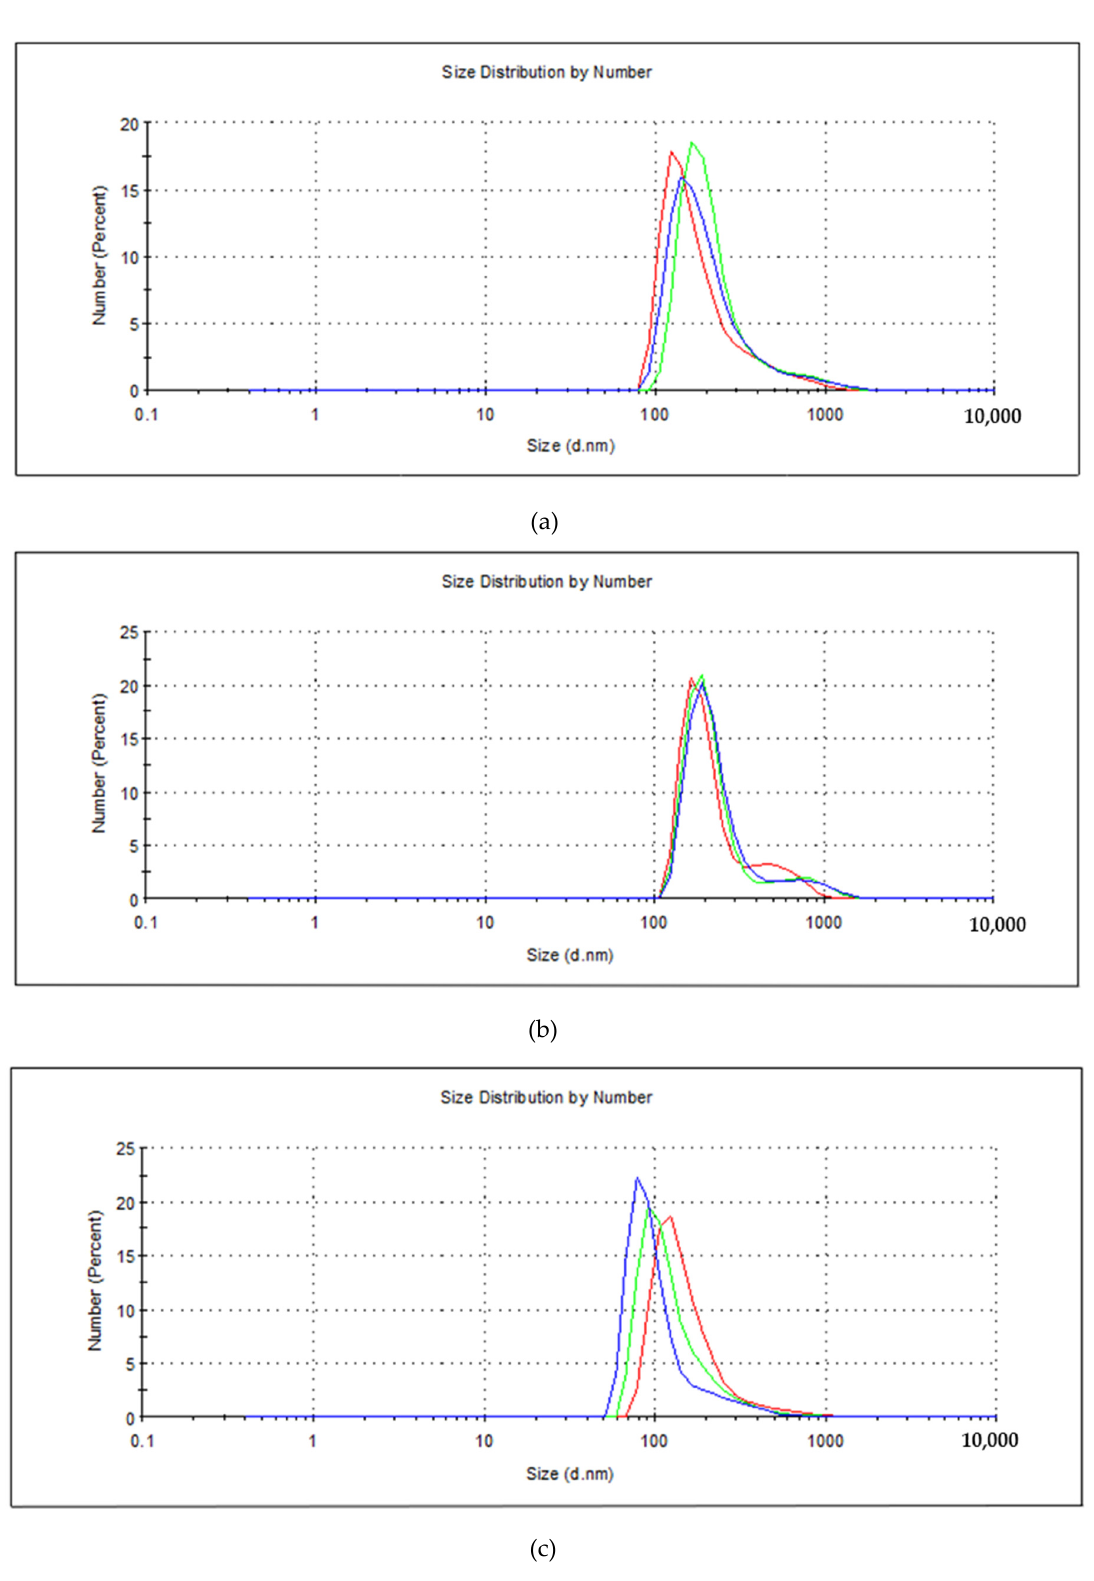
Figure 6. Results of DLS measurements for the number of particles in % of mechanochemically prepared NiTe ( a ), NiTe 2 ( b ) and Ni 2 Te 3 ( c